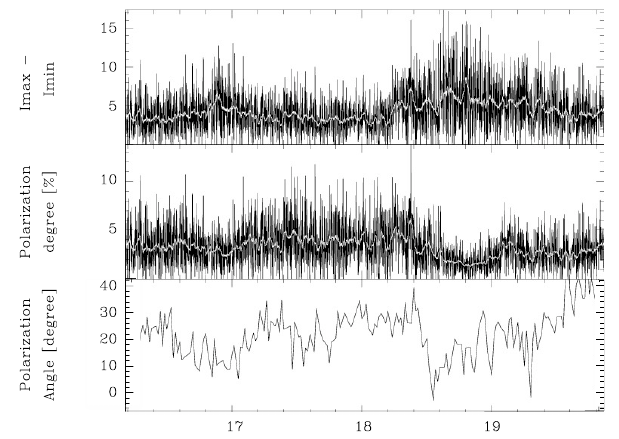
Fig. 3. 17 January 2007 with corrected polarisation direction. Hours are in UT. A faint aurora occurs slightly before 17:00UT and a stronger one between 18:20 and 19:10UT, corresponding to the po- larisation direction rotations. Intensities are in arbitrary unit. The polarisation direction was named polarisation angle in Lilensten et al. (2008). We keep this terminology for this figure